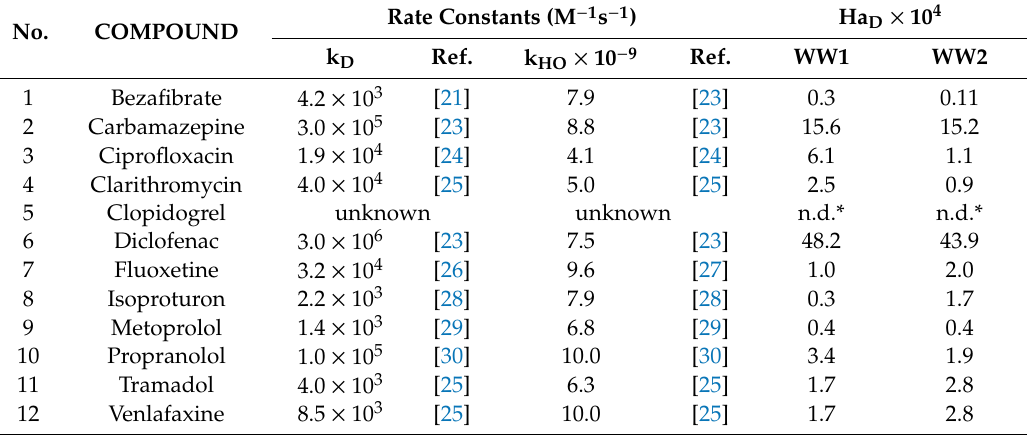
Table 2. List of numbered CECs, rate constants of their reactions with ozone and hydroxyl radical (HO • ) and Ha